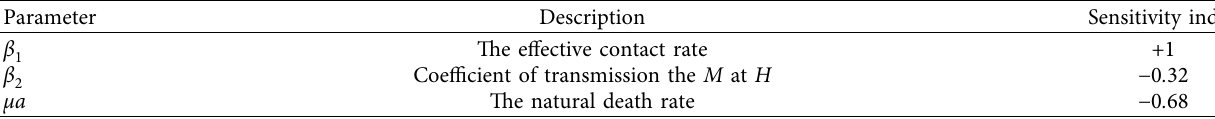
Table 1: The academic parameters used for model